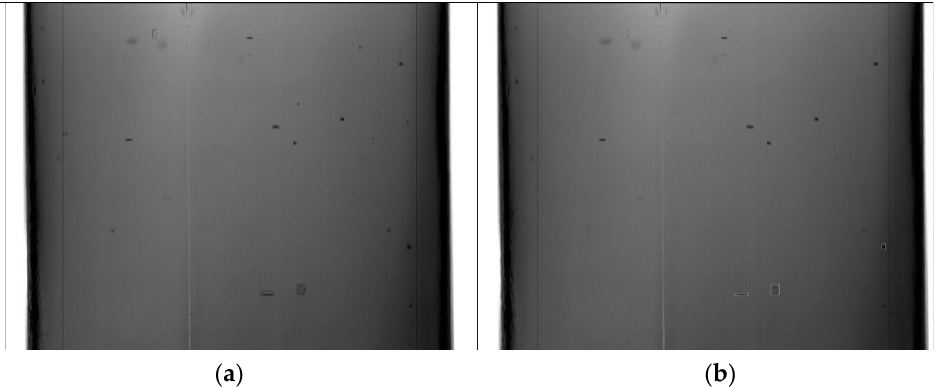
Figure 14. Example of improvement in detection of seeds: ( a ) the image has been processed with the classical image processing approach; ( b ) the image has also been processed with the deep learning- based model.